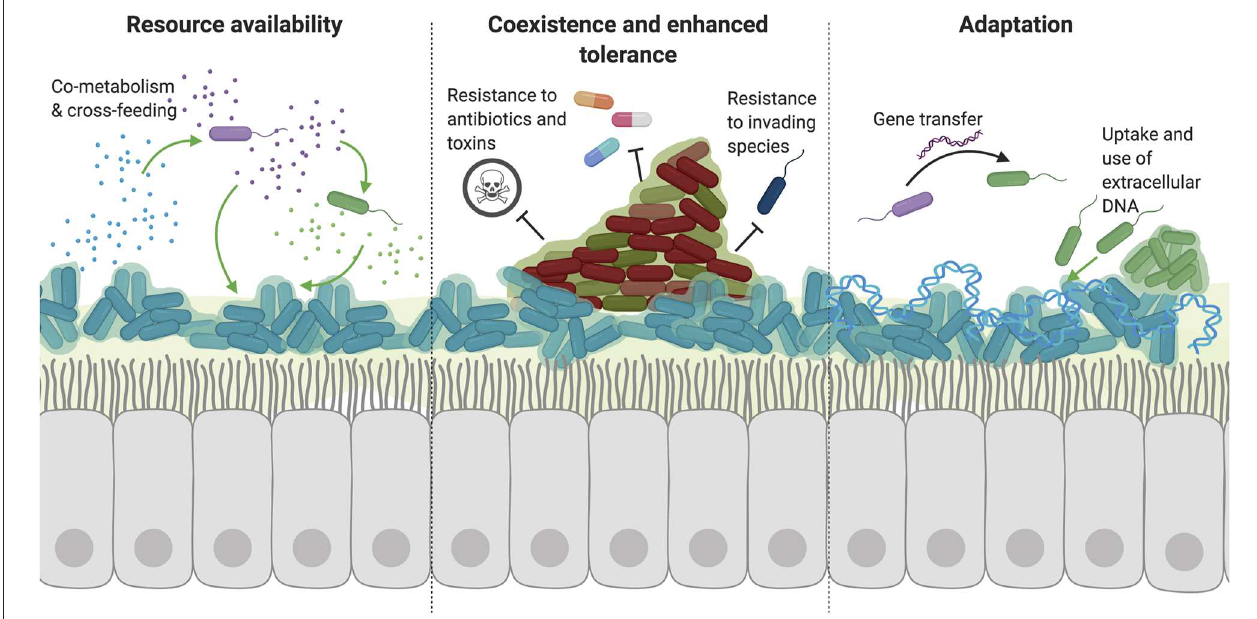
FIGURE 1 | Cooperative interactions favor the persistence of multiple species. A number of cooperative interactions have been described among species, which can broadly be broken down into three main categories. (1) Bacteria benefit from the resources released or metabolized by other species. Through mechanisms such as co-metabolism and cross-feeding, species can utilize complex nutrients that they may be unable to metabolize or access themselves. Additionally, the secretion of public goods from one species (such as siderophores, enzymes, or signaling molecules) also benefits neighboring bacteria by releasing resources into the extracellular environment. (2) The coexistence of multiple species of bacteria in a polymicrobial biofilm also allows the sharing of resources and cross-species signaling due to the close proximity of these species. Importantly, certain species can protect and shield other neighboring species in a biofilm through enhanced tolerance to antibiotics, immune radicals, and other toxic small molecules. (3) Interactions with other species also result in adaptation to improve survival in the host environment. While many organisms might evolve to evade toxic effects from competitive species, adaptation also occurs through horizontal gene transfer and uptake of exogenous bacterial DNA from the environment. The presence of this DNA alone can also aid in biofilm formation through incorporation into the extracellular biofilm